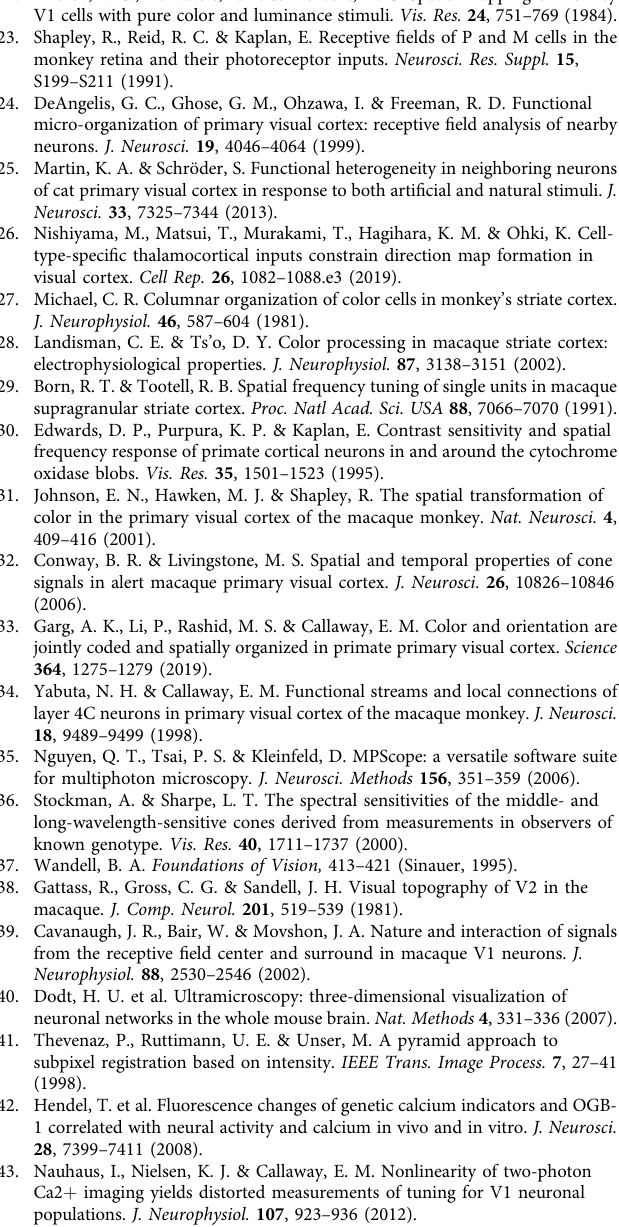
Supplementary Table 1, and none were excluded except for failed labeling with calcium indicator. Representative micrographs (e.g., color clusters in Fig. 1) highlight observations consistent across all